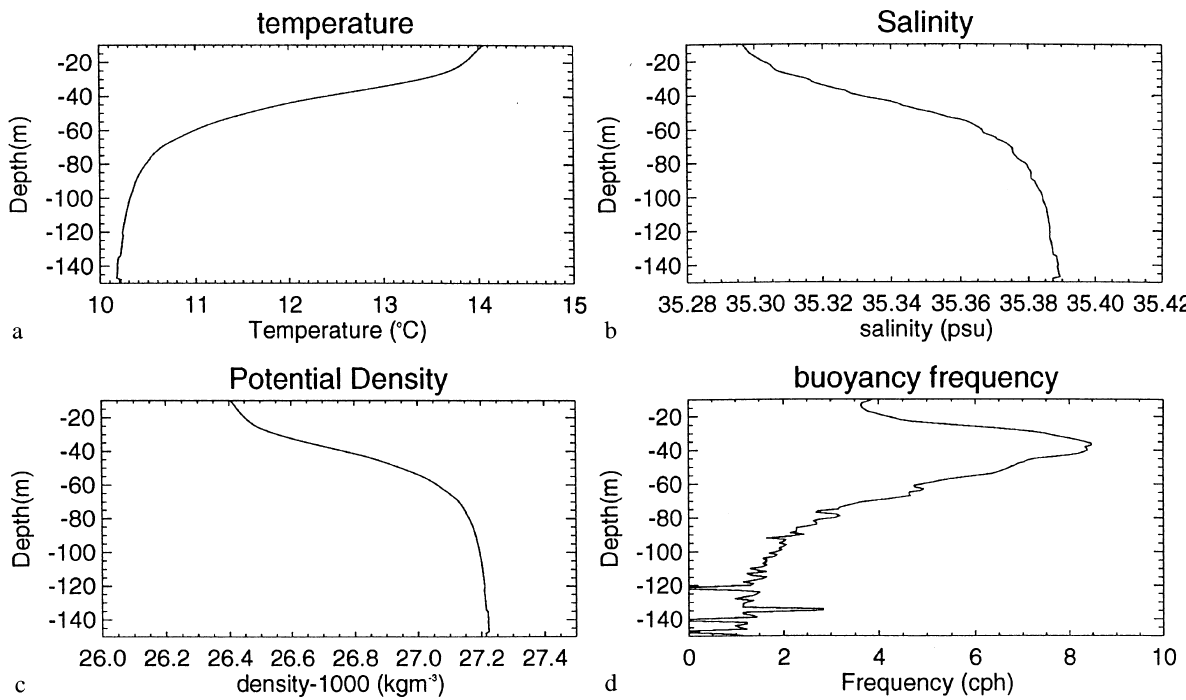
Fig. 10a–d. Mean profiles from 12–14 August, 1996 from SESAME data. a Temperature in (cid:176) C, b salinity in psu, c potential density in kgm ) 3 and d buoyancy frequency N defined by Eq. 2